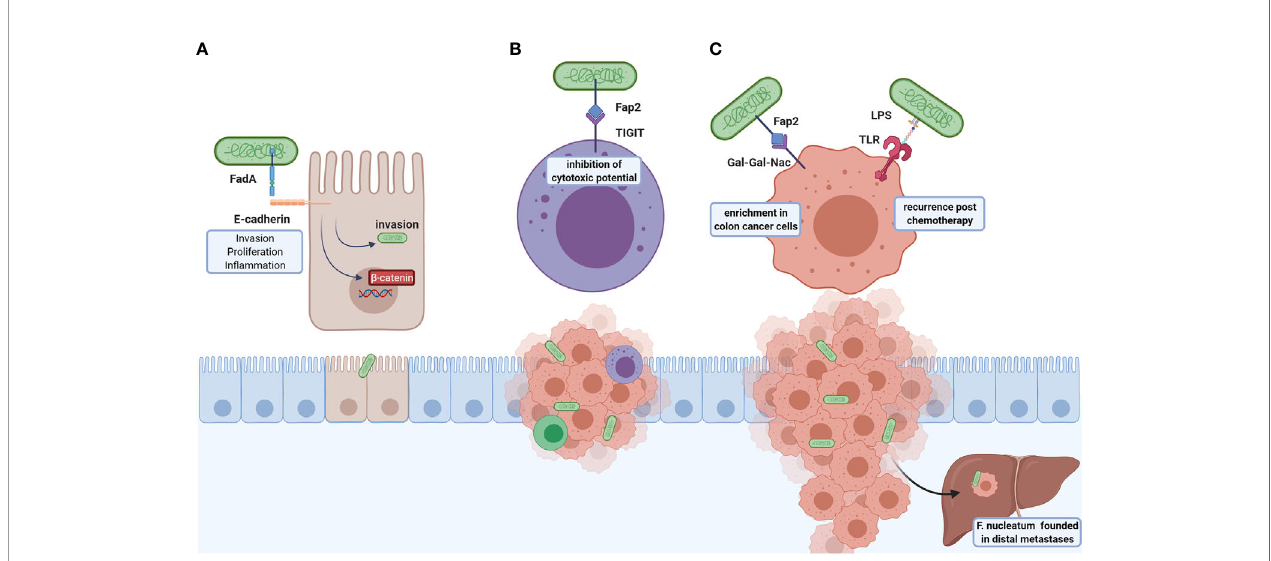
FIGURE 2 | Roles of F. nucleatum in CRC tumoral development and metastasis. F. nucleatum virulence factors are FadA and Fap2: (A) FadA is an adhesin that binds to E-cadherin and allows bacterial invasion, which also induces the colonocyte proliferation through ß-catenin signaling and NFkB2-associated pro- in fl ammatory response. (B) Fap2 interacts with the TIGIT inhibitory receptor of NK cells resulting in cytotoxic inhibition, leading to immune evasion. (C) This bacterium associates with post-chemotherapy recurrence, suggested through LPS-TLR4 interaction activating autophagy, and altering chemotherapy response. Furthermore, Fap2 recognizes and binds to Gal-GalNac expressed in colorectal tumor cells; high F. nucleatum content found in distal metastases. The above-mentioned effects indicate that this bacterium participates in both carcinogenic and metastatic processes and may be a potential therapeutic